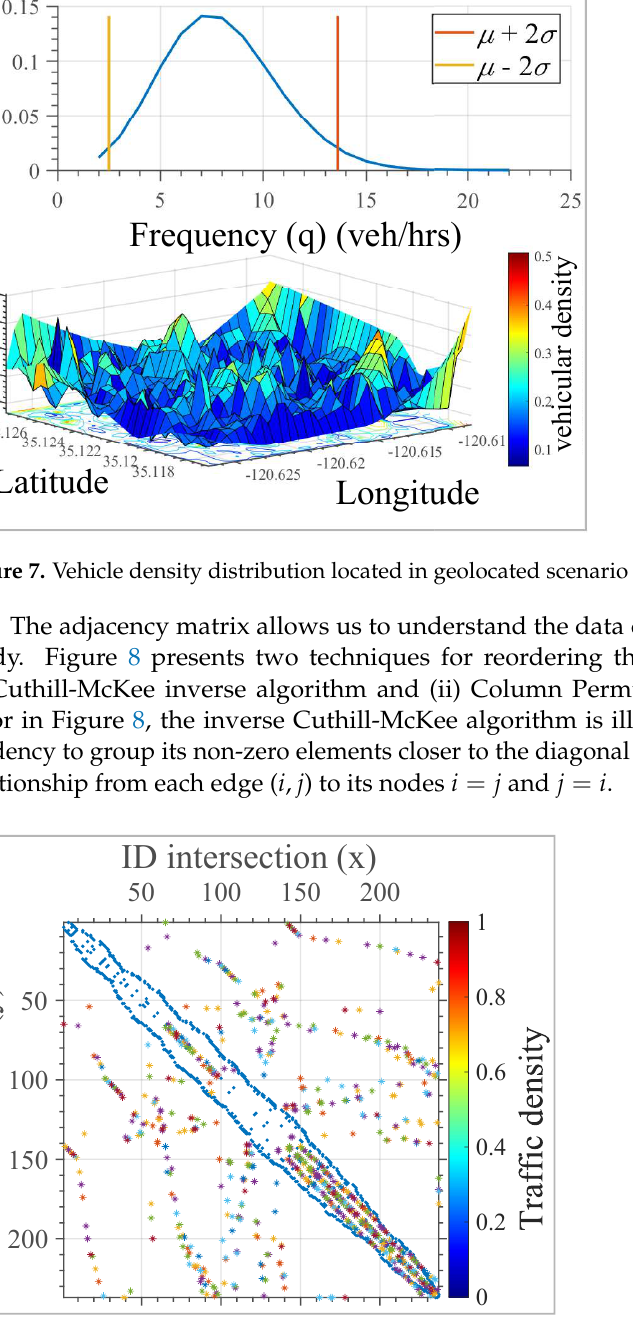
Figure 8. Case A: Distribution of connectivity matrix and its nodal